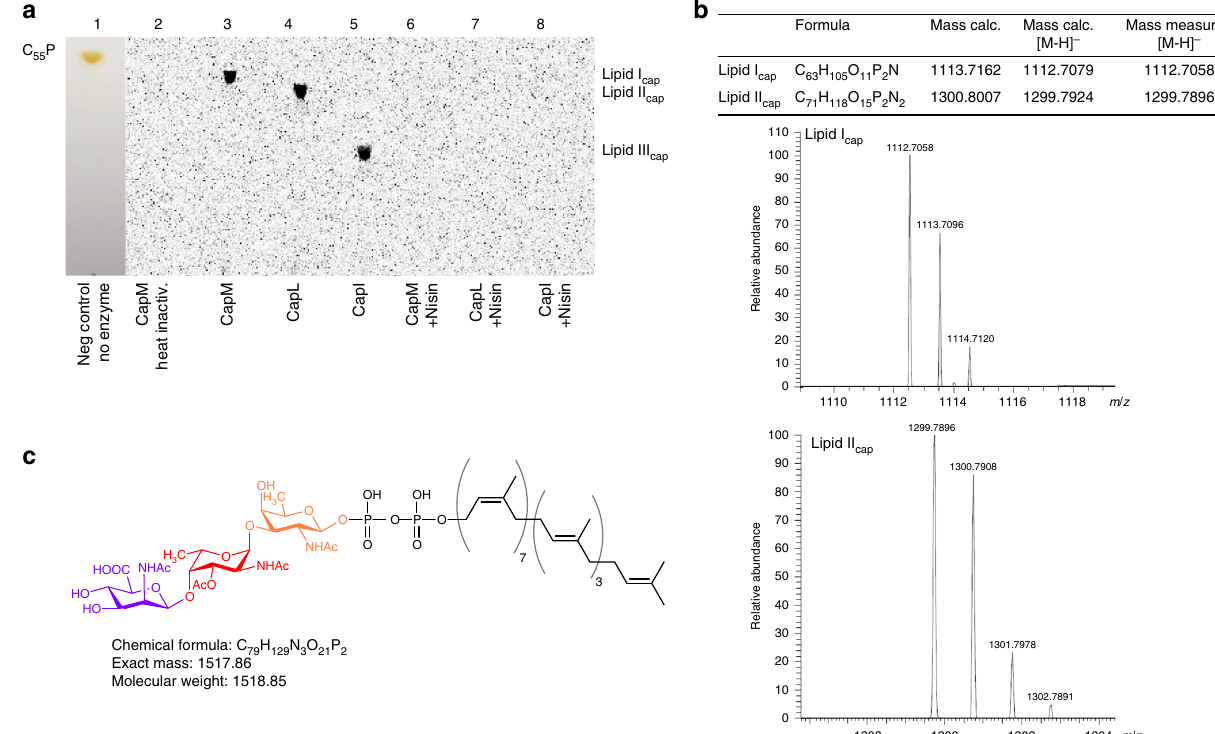
Fig. 2 Synthesis of CP lipid intermediates. Glycosyltransferases (GT) CapM, CapL and CapI catalyze the in vitro synthesis of CP lipid intermediate lipid I cap (C 55 PP- D -FucNAc), lipid II cap (C 55 PP- D -FucNAc- L -FucNAc) and lipid III cap (C 55 PP- D -FucNAc- L -FucNAc- D -ManNAcA), respectively. a Puri fi ed GTs were incubated with the respective puri fi ed acceptor lipid substrate in the presence of radiolabeled UDP-activated sugars. After extraction with BuOH/PyrAc, synthesis products were analyzed by TLC and phosphoimaging. Counterstain with iodide (lane 1) was used to visualize the migration behavior relative to C 55 P. Nisin, known to bind to the pyrophosphate-sugar moiety of cell wall lipid intermediates was added posterior and formed complexes with all lipid cap intermediates that are not extracted from the reaction mixture. Heat-inactivated CapM was used as a negative control. b ESI-MS-analysis of lipid I cap and lipid II cap. The peaks at m/z 1112.70 and 1299.78 correspond to the negatively charged lipid I cap and lipid II cap molecules, respectively. c Structure of the ultimate CP lipid intermediate lipid III cap . Sugar residues are colored: D -FucNAc (orange), L -FucNAc (red), D -ManNAcA